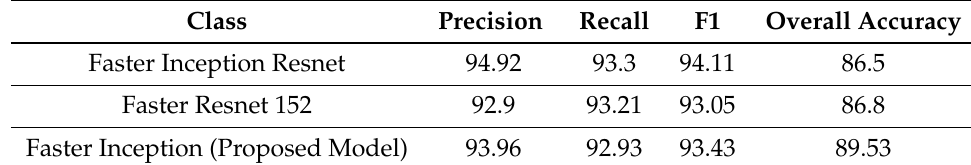
Table 8. Comparison with other object detection frameworks.